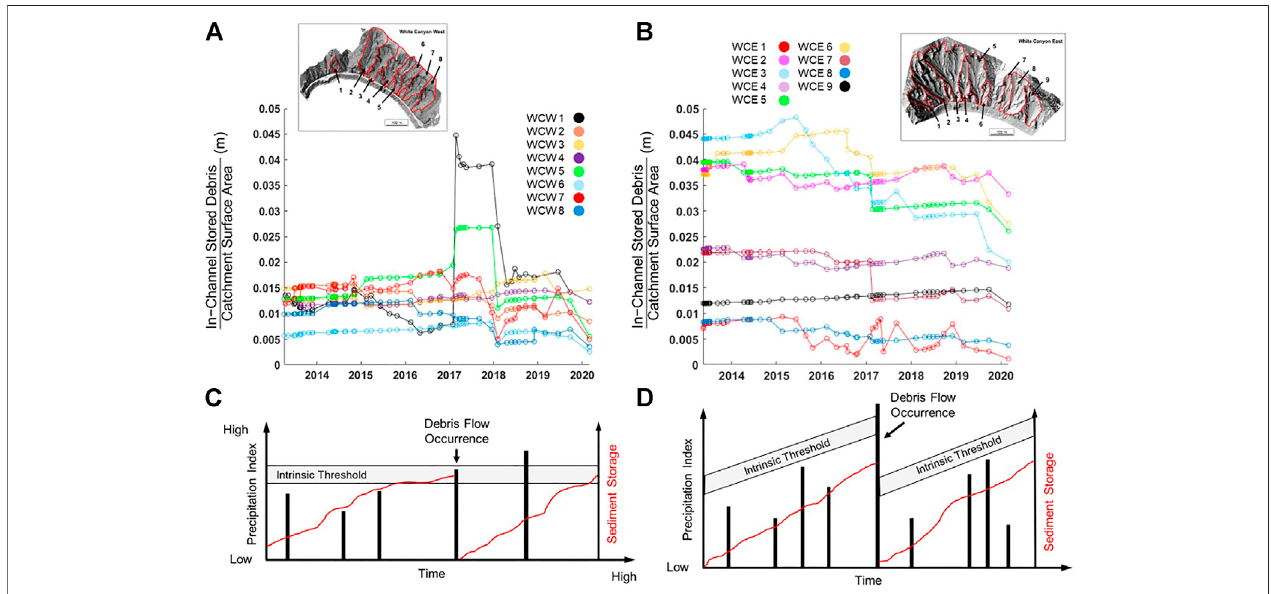
FIGURE 14 | Overview of the estimated in-channel stored sediment for three of the analyzed channels on WCW. Upper graph corresponds to the volume of estimated in-channelstoredsedimentforeachTLSscan(black)andthevolumeofrockfallvolumeaddedtothechannelduringtheperiodelapsedbetweenscans(blue). Example channels from WCW are displayed: (A) Channel 1, (B) Channel 2, (C) Channel 5.